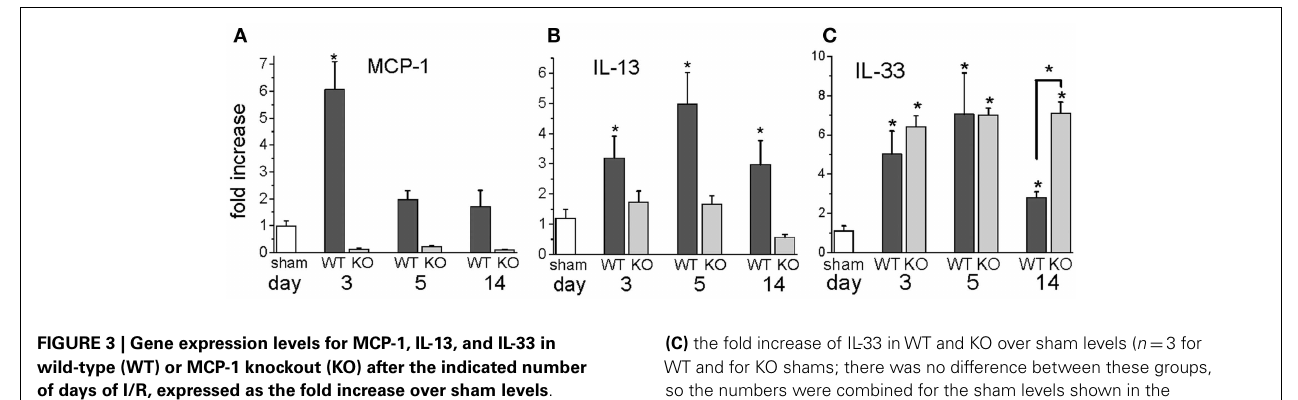
(C) the fold increase of IL-33 inWT and KO over sham levels ( n = 3 for WT and for KO shams; there was no difference between these groups, so the numbers were combined for the sham levels shown in the graph; * p < 0.05).The graph for IL-13 is reprinted with permission from